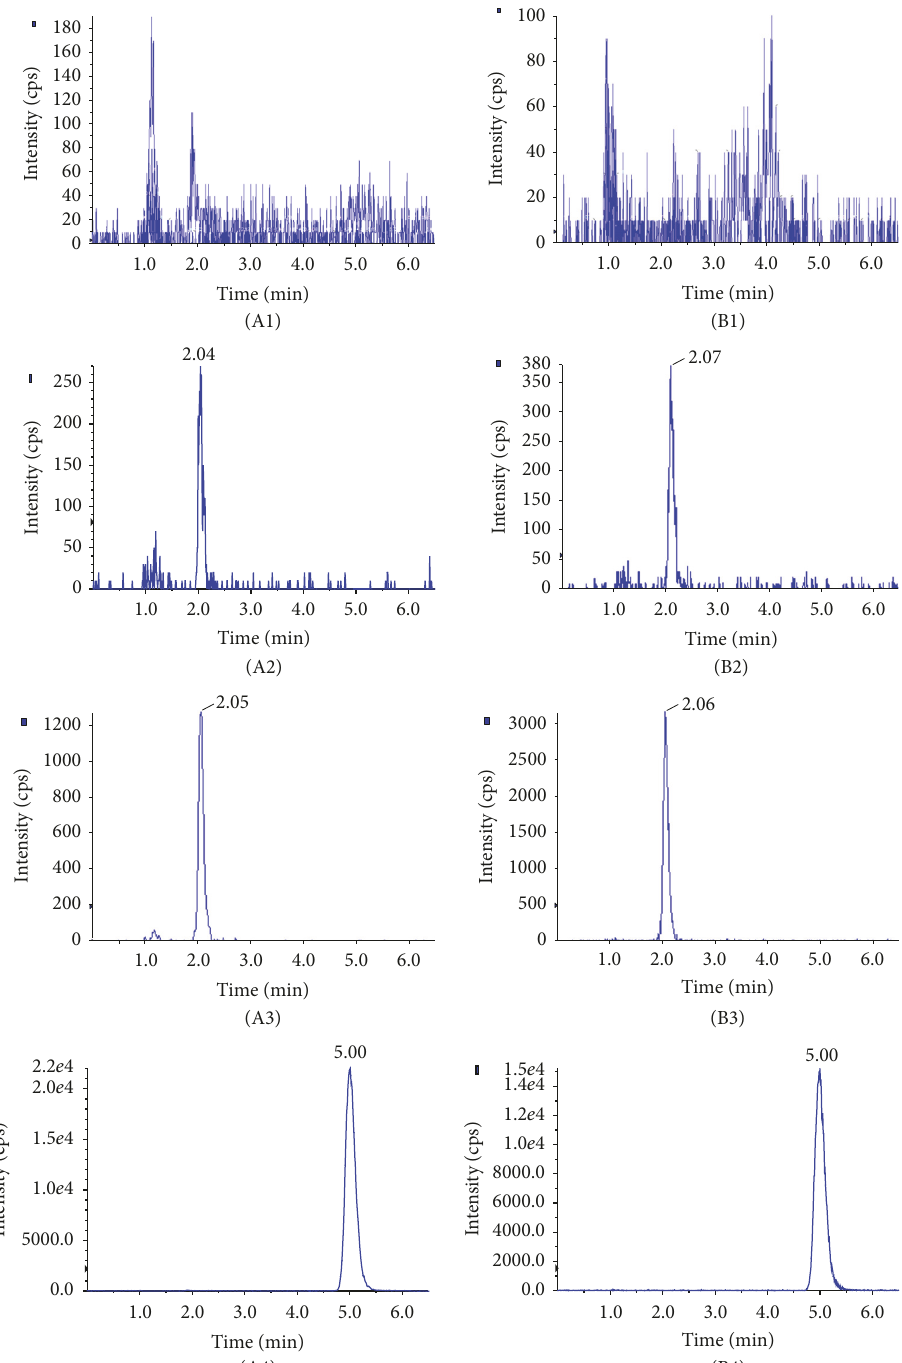
Figure 3: Representative MRM chromatograms: (A1) blank plasma, (A2) blank plasma spiked with epimedin B at LOQ, (A3) rat plasma sample obtained at 0.5 h after administration, (A4) blank plasma spiked with IS, (B1) blank liver, (B2) blank liver spiked with epimedin B at LOQ, (B3) rat liver sample obtained at 0.5 h after administration, and (B4) blank liver spiked with IS.